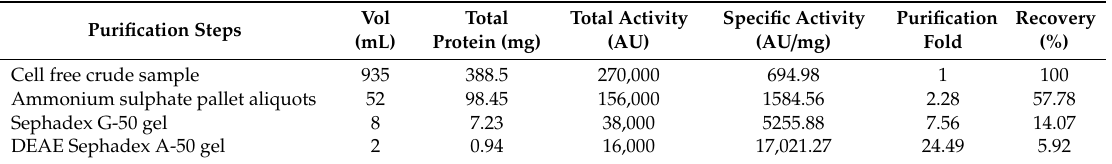
Table 3. Purification steps of peptide